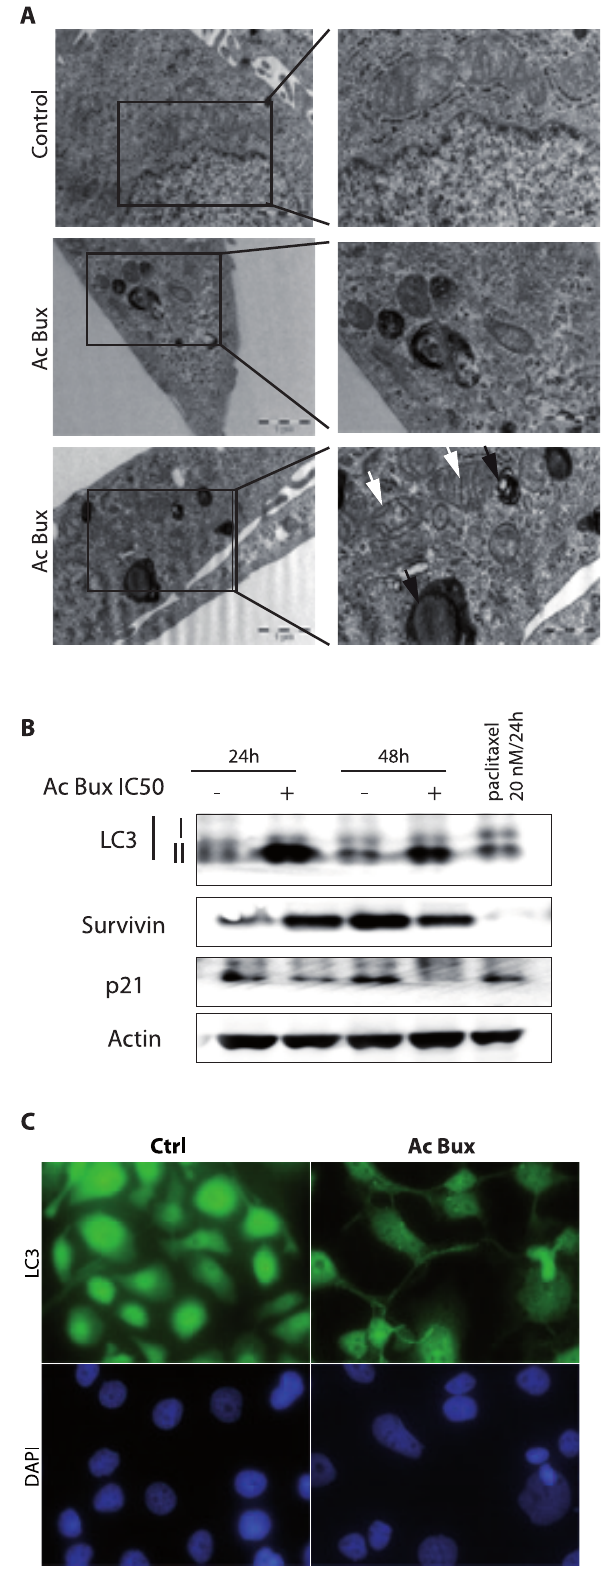
Figure 5. Acetonic extract of Buxus induces autophagy in MCF10CA1a cell line. A. Transmission electron microscopy pictures of untreated and Buxus extract-treated MCF10CA1a cells (IC 50 , 72 h). Black arrows show degradative autophagic vesicles. White arrows